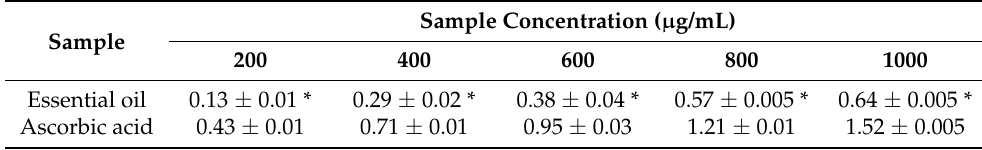
Table 2. Reducing power of A. visnaga L. essential oil at different